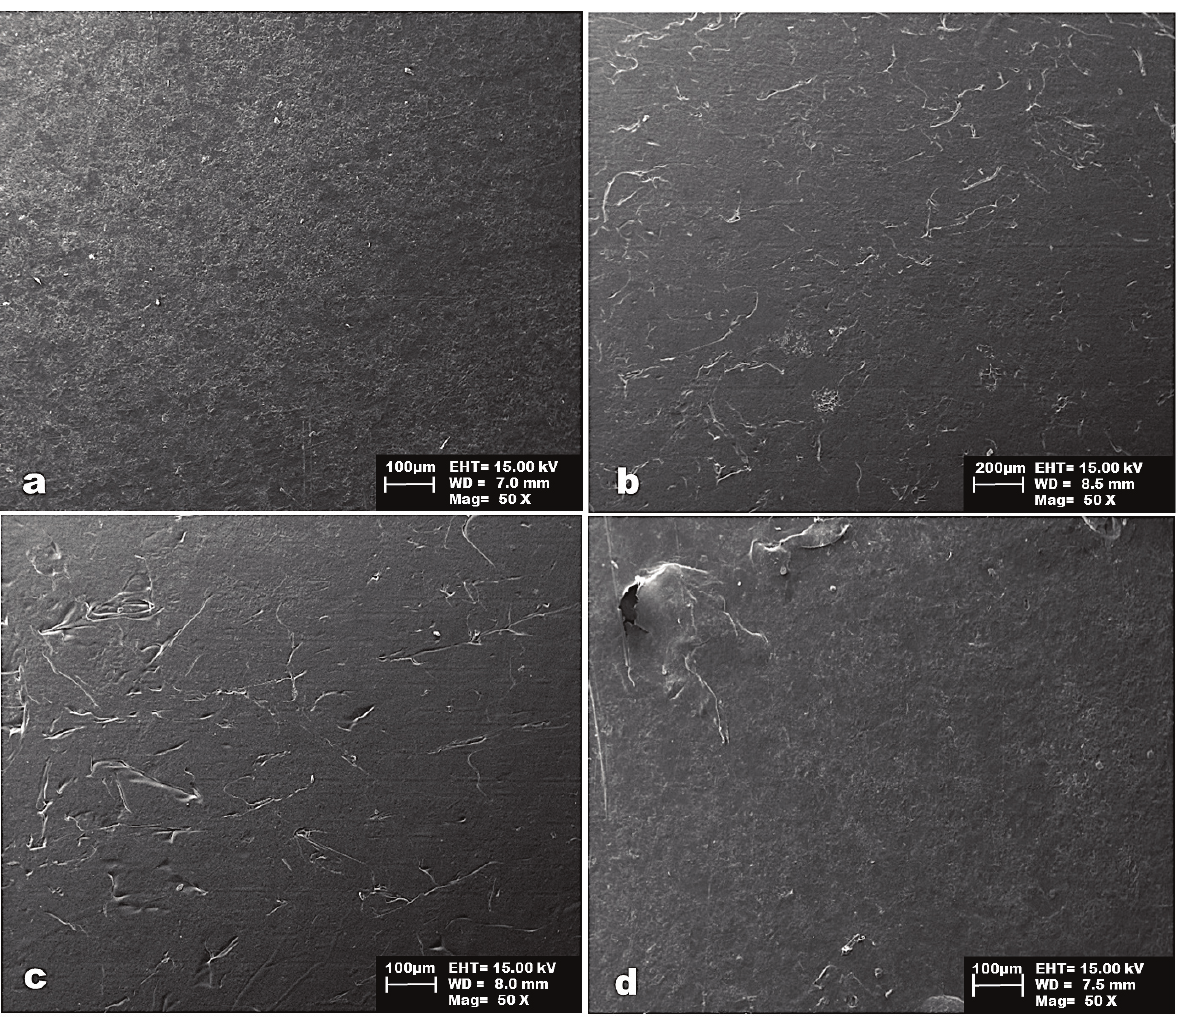
Fig. 3. SEM micrographs of pure PP and various composites fabricated through compression molding: (a) pure PP, (b) 10% cotton fibre fraction, (c) 30% fibre content and (d) 40% fibre